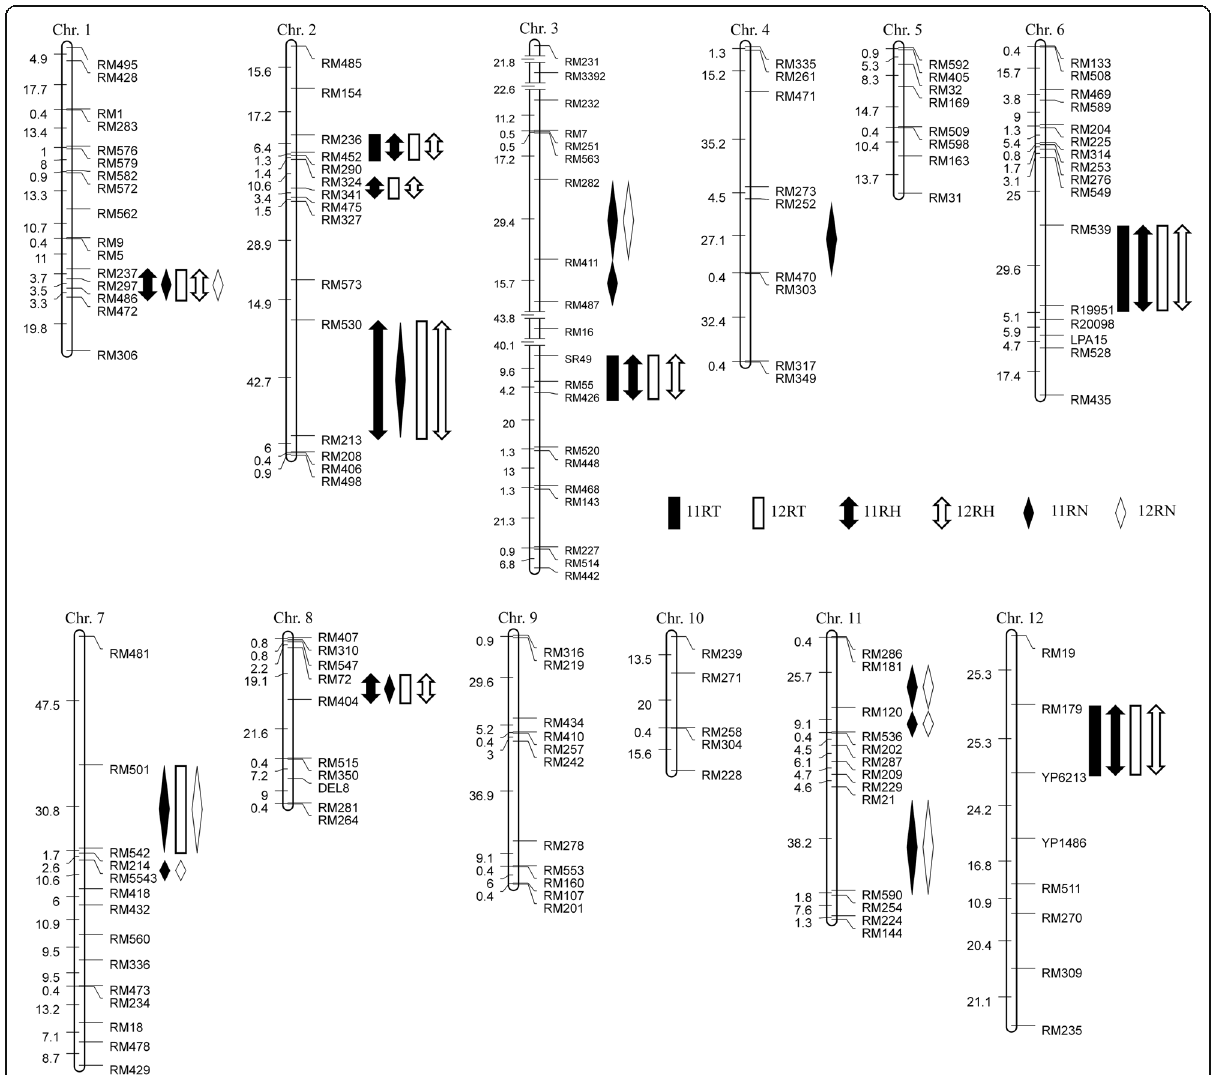
Fig. 3 Distribution of QTLs for blast resistance in the Jin23B/CR071 population on the genetic linkage map. 11RT and 12RT, leaf blast resistance at tillering stage in 2011 and 2012. 11RH and 12RH, leaf blast resistance at heading stage in 2011 and 2012. 11RN and 12RN, neck blast resistance at maturation stage in 2011 and